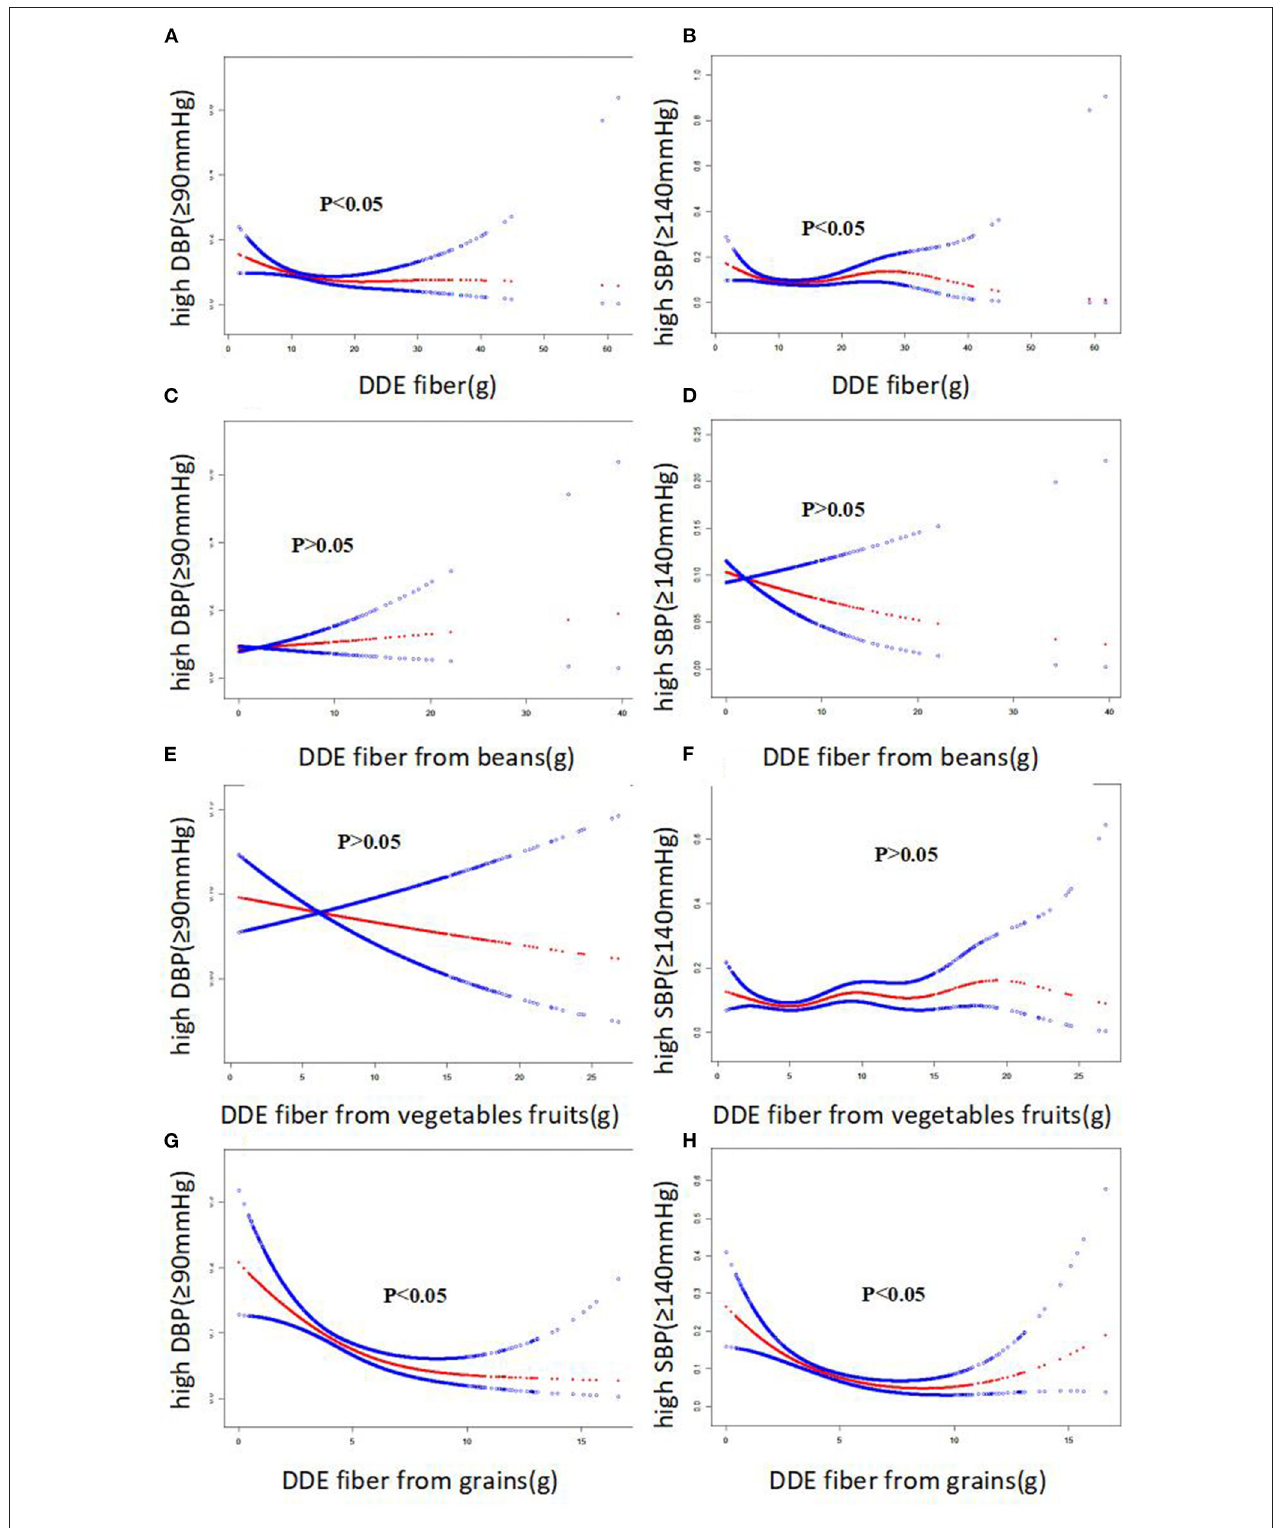
FIGURE 3 | The smooth curve of the associations between dietary fiber intake and risk of systolic and diastolic hypertension, respectively.